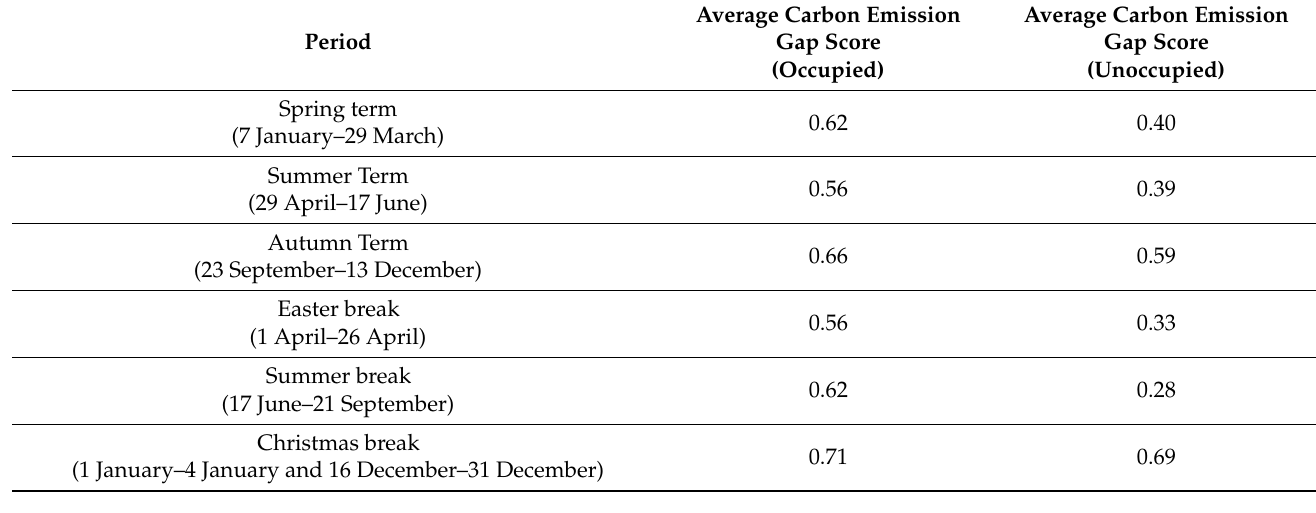
Table 4. Average carbon emission gap score in segmented periods.